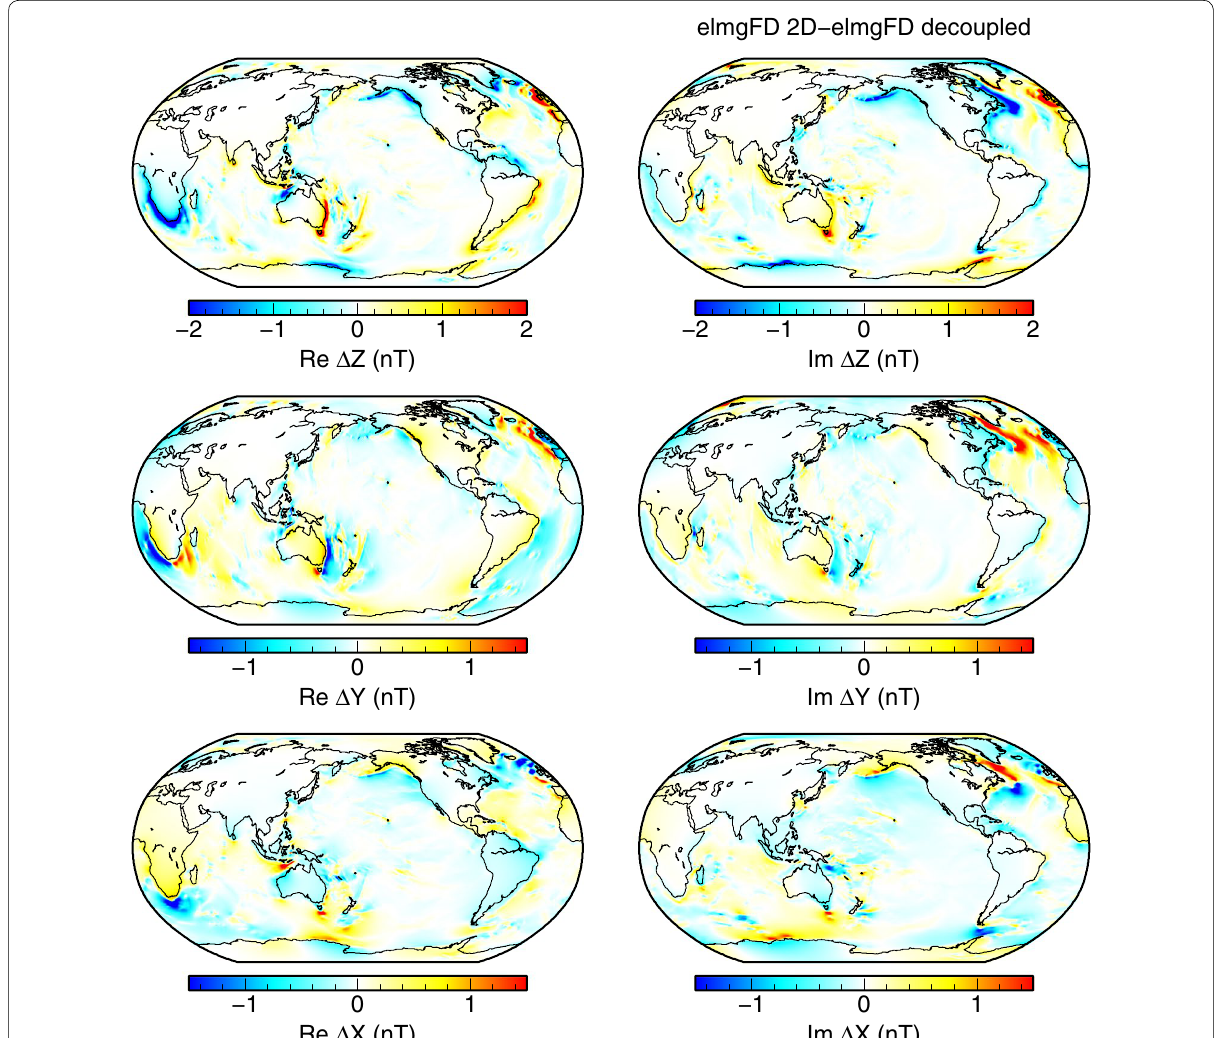
Fig. 9 Effect of galvanically decoupled mantle. Differences between the 2-D solution and a unimodal solution without toroidal magnetic field, i.e. galvanically decoupled from the underlying conductive mantle. Both solutions were calculated at the Earth’s surface with the elmgFD code at j max =